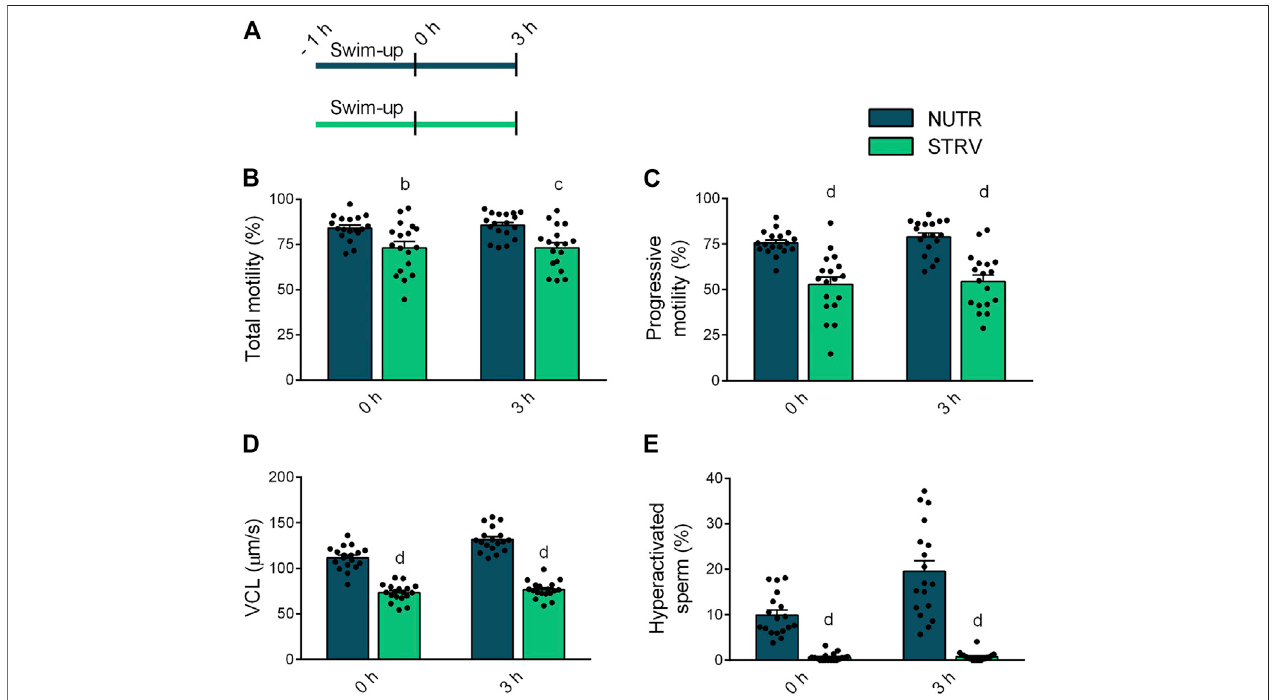
FIGURE 1 | Sperm motility in the presence or absence of exogenous nutrients. (A) Experimental design. Motile human sperm were selected by swim-up in BWW containing glucose, lactate and pyruvate (NUTR) or in medium devoid of glucose, pyruvate and lactate(STRV). Motility parameterswere recorded by CASA immediately after swim-up (0 h) and after 3-h incubation in the same medium in capacitating conditions. (B) Total motility. (C) Progressive motility. (D) Curvilinear velocity (VCL). (E) Hyperactivatedsperm.Resultsareexpressedasmean ± SEM, n (cid:1) 18experiments,8donors( ≤ 3samplesperdonor). b p < 0.01, c p < 0.001, d p < 0.0001vs.NUTR. Two-way ANOVA, and Bonferroni ’ s multiple comparison test.